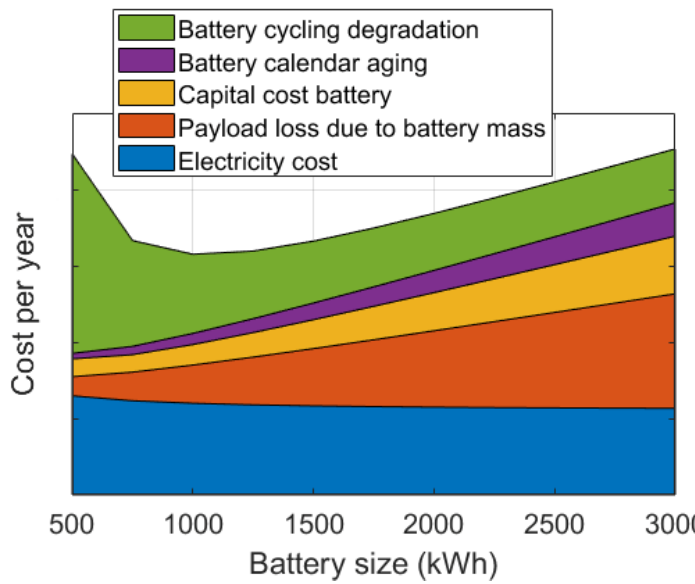
Figure 15. Illustrative example of costs depending on battery